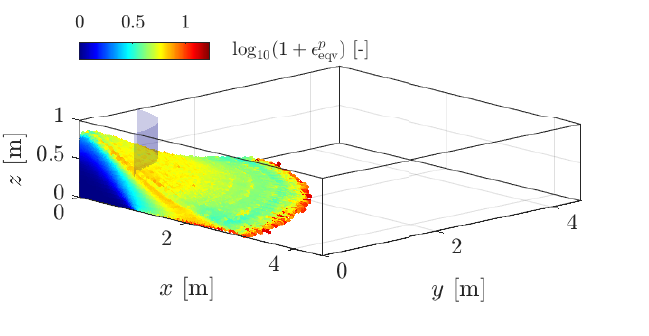
Figure 9. Final morphology of the granular deposit for λ 0 = 2 and D = 0.05. The colour denotes the (cid:82) t ( 2 equivalent plastic strain (cid:101) p eqv = ˙ (cid:101) p : ˙ (cid:101) p ) 1 2 d t with the plastic strain rate tensor ˙ (cid:101) p , the symbol : 3 t 0 denotes the inner product operator. The transparent blue shell indicates the initial maximum extent of the granular